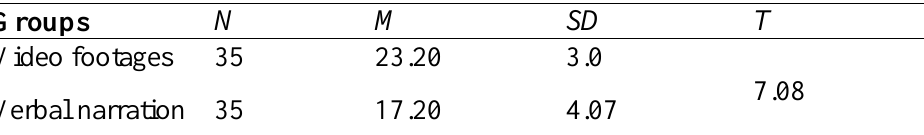
Table 1 Means, standard deviations and t-value of the academic learning of Group A and Group